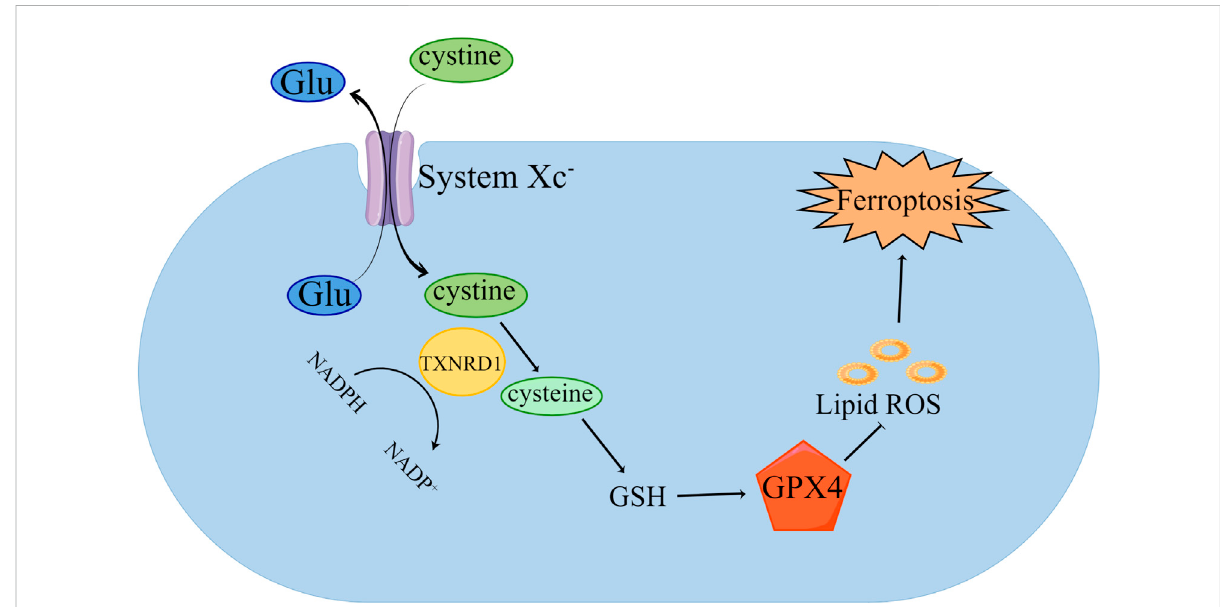
FIGURE 1 Inhibition of GPX4 induced ferroptosis. Cystine istransportedinto cells bySystem xc — and transformed into cysteine by TXNRD1, which further synthesizesGSH.GPX4usesGSHtoremovethephospholipidperoxide(PLOOH).ThedecreaseofGSHleadstotheweakeningofGPX4 ’ sscavenging effect on lipid peroxides, thus inducing